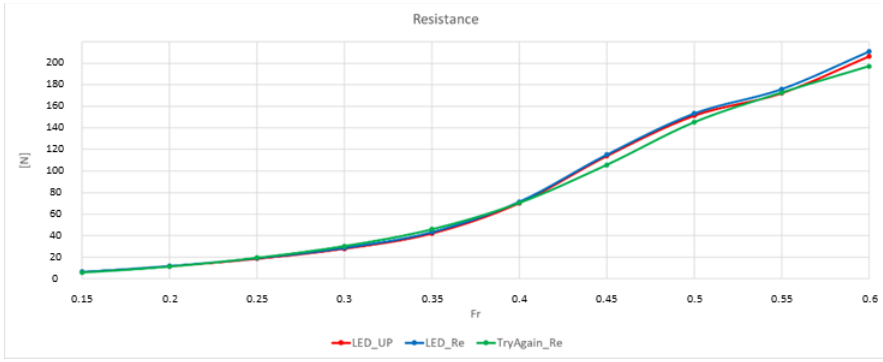
Figure 21. Comparison between the resistance curves of LED, TryAgain and LED_UP_06.